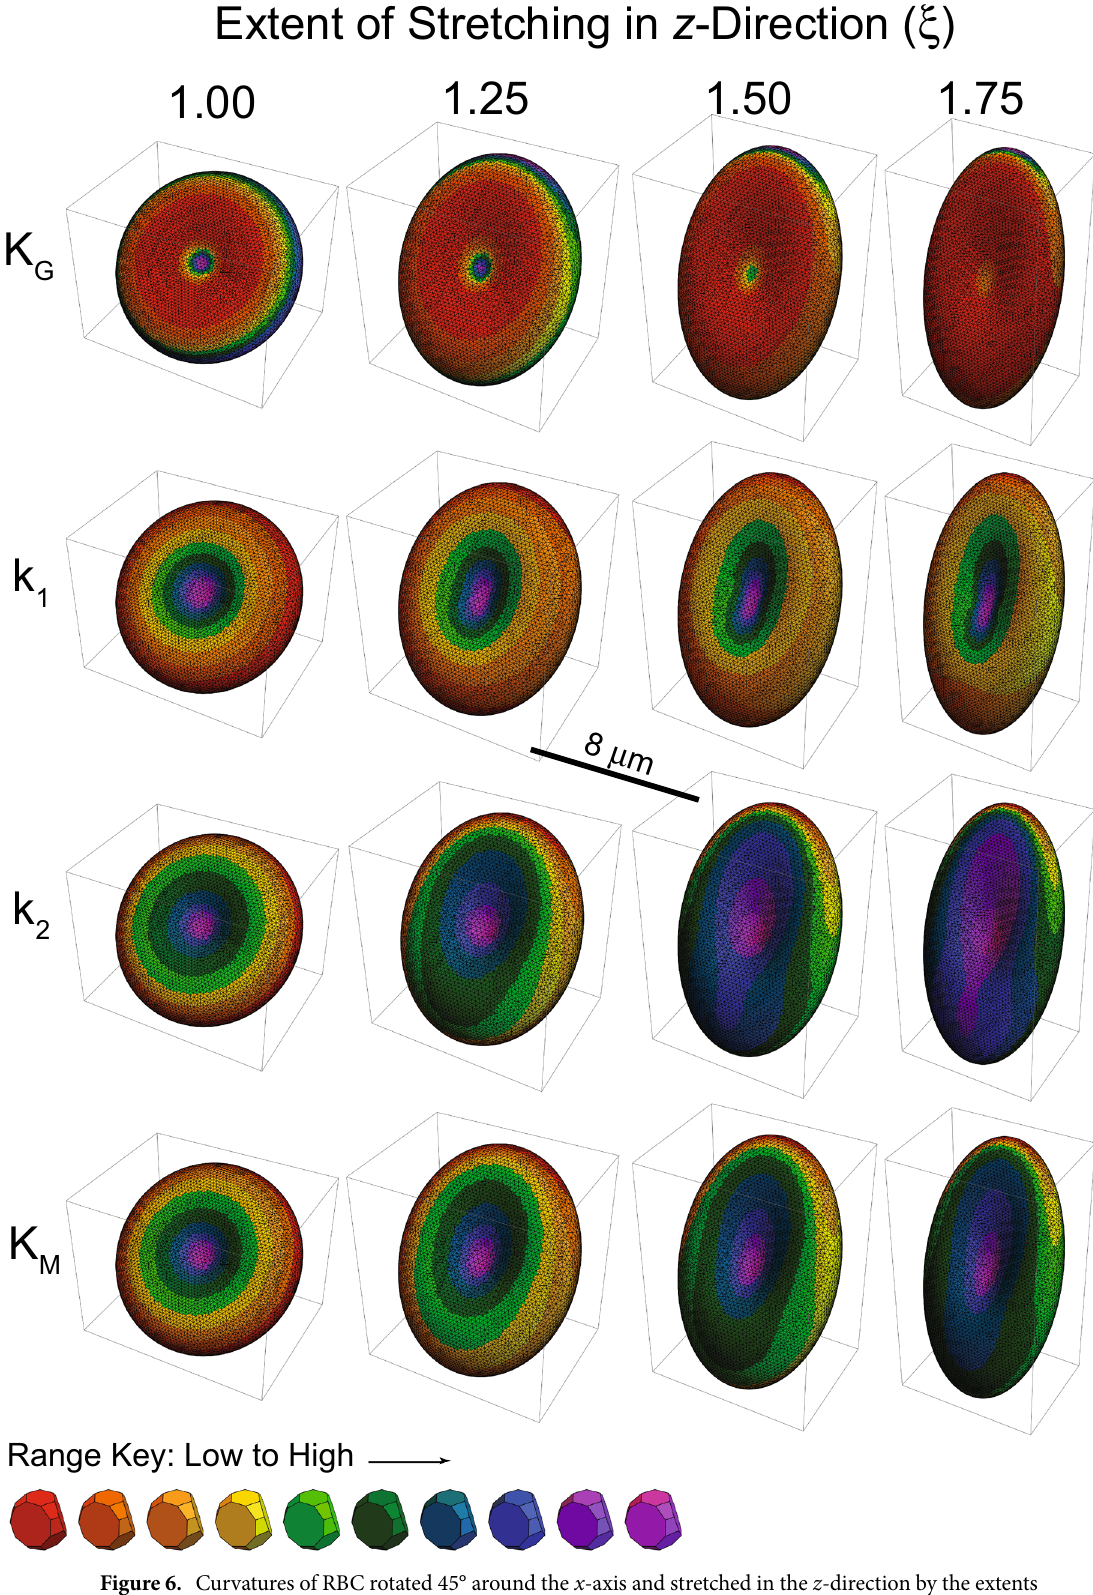
Figure 6. Curvatures of RBC rotated 45° around the x -axis and stretched in the z -direction by the extents (ξ) indicated above. The relaxed RBC had the same dimensions as in Fig. 1. The central scale bar indicates d = 8 μm, the main diameter of the fully relaxed RBC. K G denotes Gaussian Curvature; k 1 , Principal Curvature (maximum); k 2 , Principal Curvature (minimum); and K M , Mean Curvature. The values of the respective curvatures across the 10 subdivisions of the domain of values are those shown in the central column of the polygonal graphs in Fig.